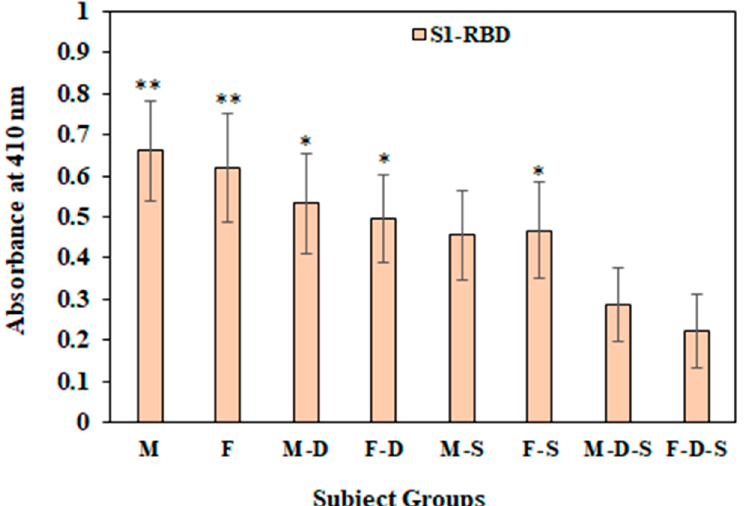
Figure 6. Detection of serum autoantibodies against ROS modified proteins (BSA and Lys) and S1-